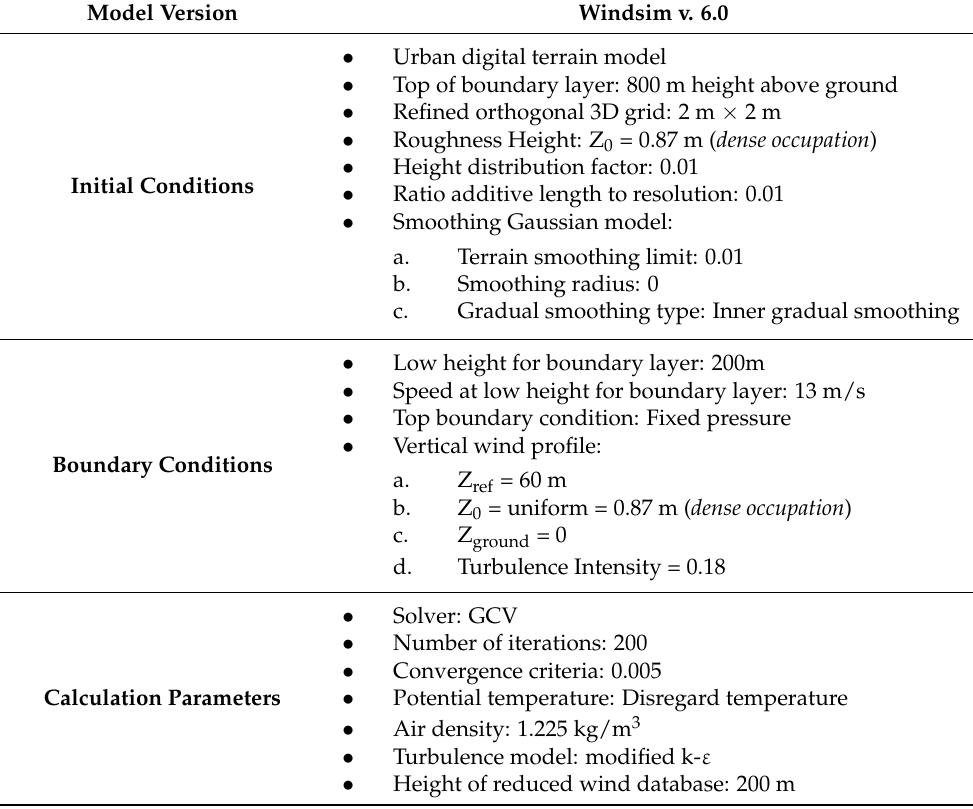
Table 2. Initial and boundary conditions imposed for the Windsim